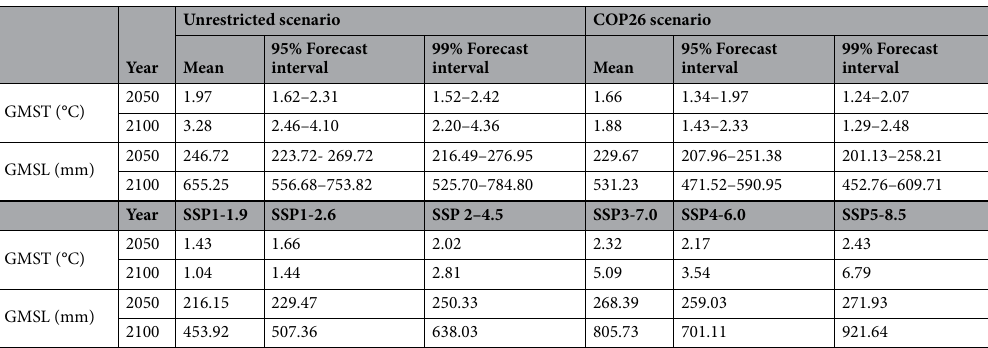
Table 1. Predicted means and forecast intervals (95% and 99%) of GMST rise and GMSL rise by 2050 and by 2100 under unrestricted or COP26 restrictions on greenhouse gas emissions; and the predicted means of GMST rise and GMSL rise by 2050 and by 2100 under SSP1-1.9, SSP1-2.6, SSP2-4.5, SSP3-7.0, SSP4-6.0 and SSP5-8.5 scenarios. The baseline for GMST is the pre-industrial (1850–1900 average) level, while the baseline for GMSL is the 20-year mean value of GMSL from 1986 to 2005. The units of GMST are °C and the units of GMSL are